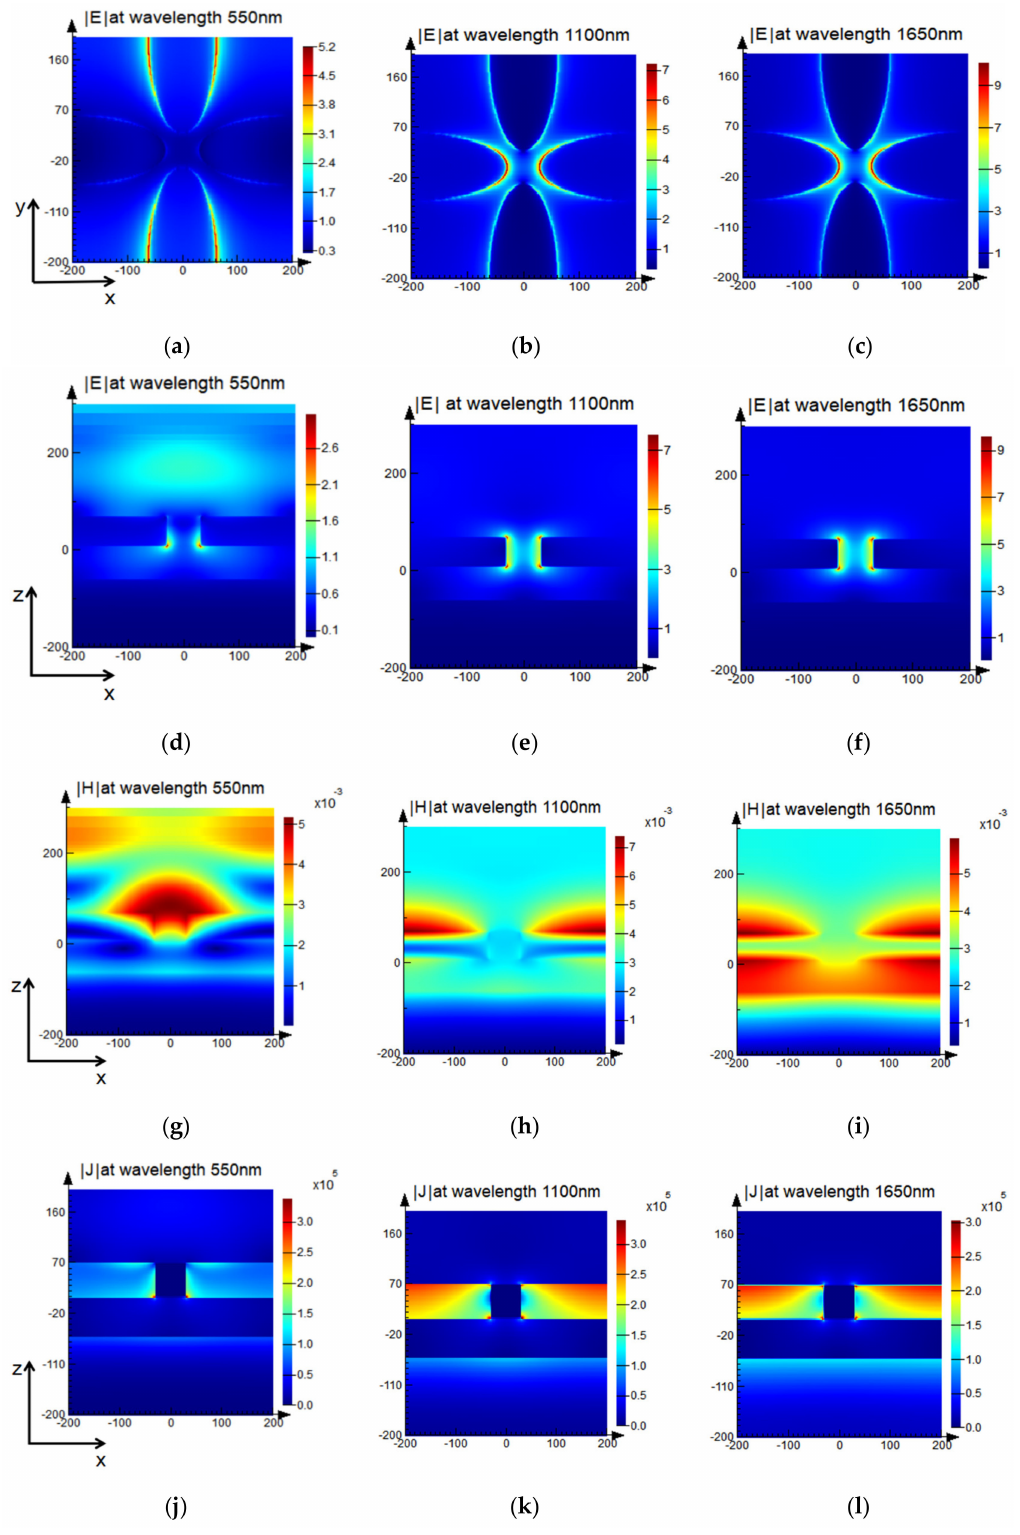
Figure 9. Electromagnetic field intensity and current distribution of the TM-polarized light with a normal incidence at various resonant wavelengths (i.e., 550, 1100, and 1650 nm). ( a – c ) Electric field intensity distribution at the interface between the SiO 2 antireflection layer and the Ti elliptical nanodisk. ( d – f ) Electric field intensity distribution in the x – z plane when y = 0. ( g – i ) Magnetic field intensity distribution in the x – z plane when y = 0. ( j – l ) Current distribution in the x – z plane when y =